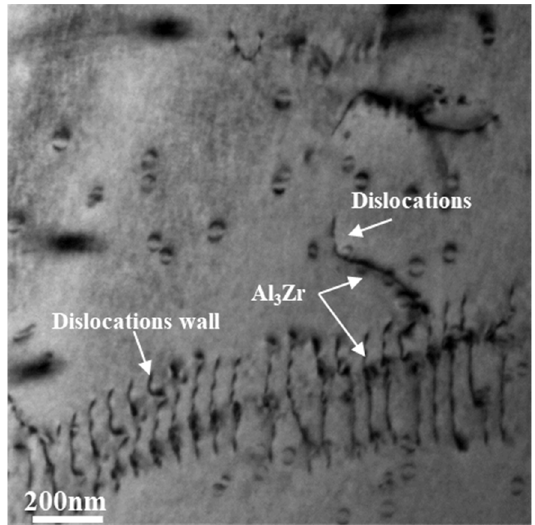
Figure 14. Al3Zr particles by repeated precipitation on dislocation.